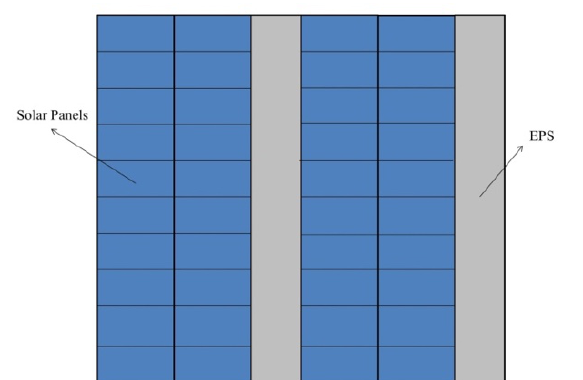
Figure 6. layout of solar panels and EPS on the water surface of the dam